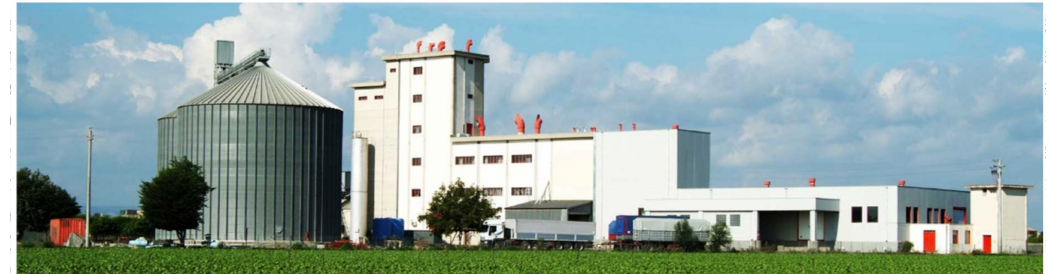
Figure 1. View of the flour mill where the heat treatment was carried